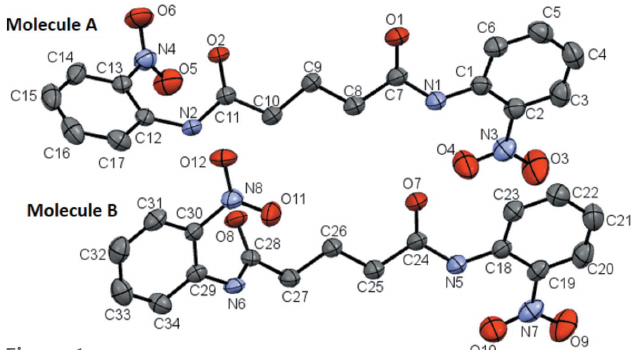
Figure 1 Molecular structure of (I), showing the atom-labelling scheme. Displace- ment ellipsoids are drawn at the 50% probability level and hydrogen atoms are omitted for